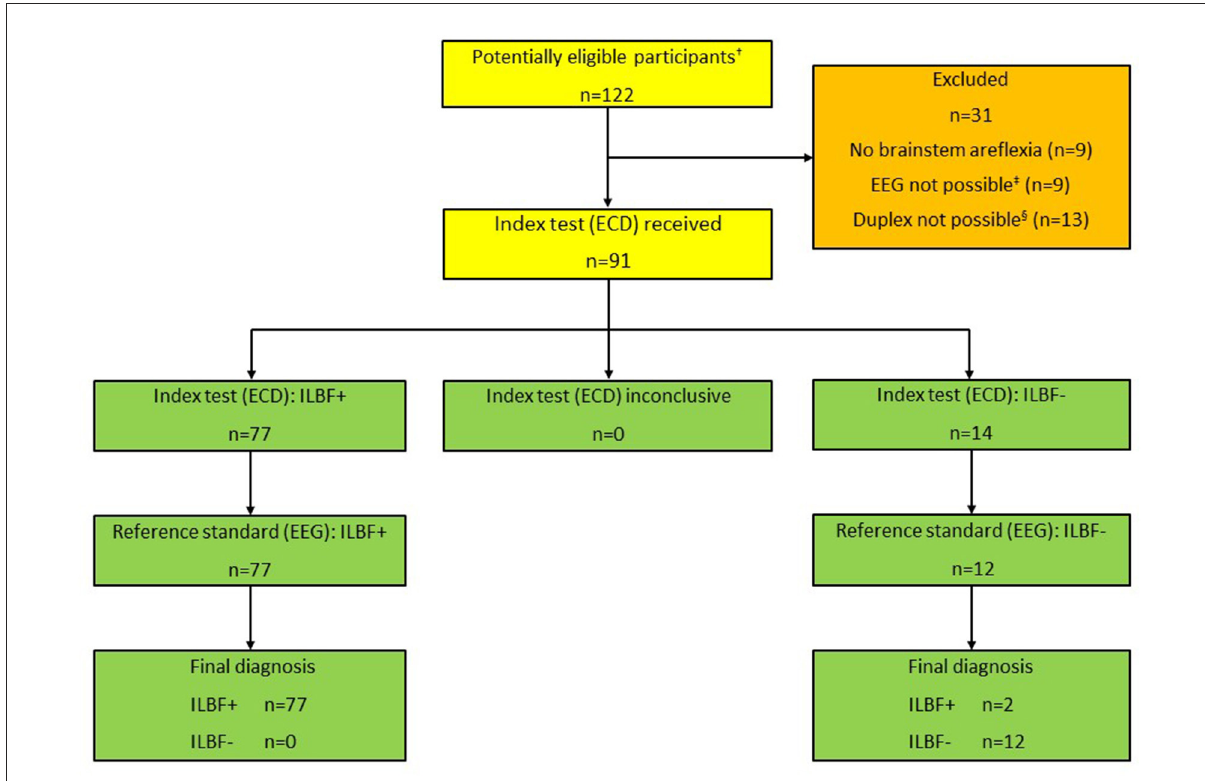
FIGURE2 Patient inclusion scheme, all patients ( n = 122). † Total number of patients that were examined as ILBF candidates 01/2019-12/2021. ‡ Due to relevant levels of analgosedatives ( n = 6), relevant COPD ( n = 3). § Due to large cranial osseus defects ( n = 8), low cardiac output (vaECMO; n = 5). ILBF + Test result consistent with irreversible loss of brain function. ILBF- Test result not consistent with irreversible loss of brain